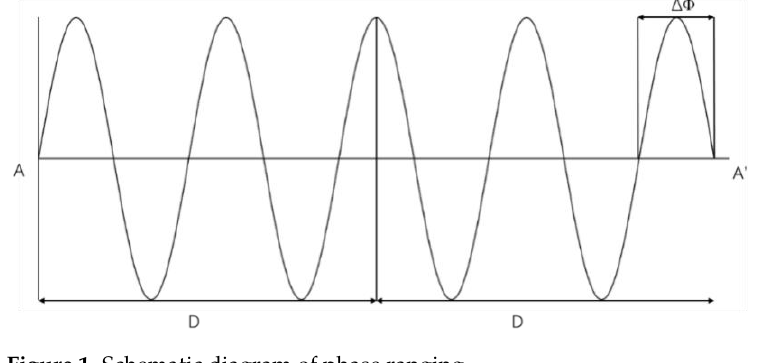
Figure 1. Schematic diagram of phase ranging.